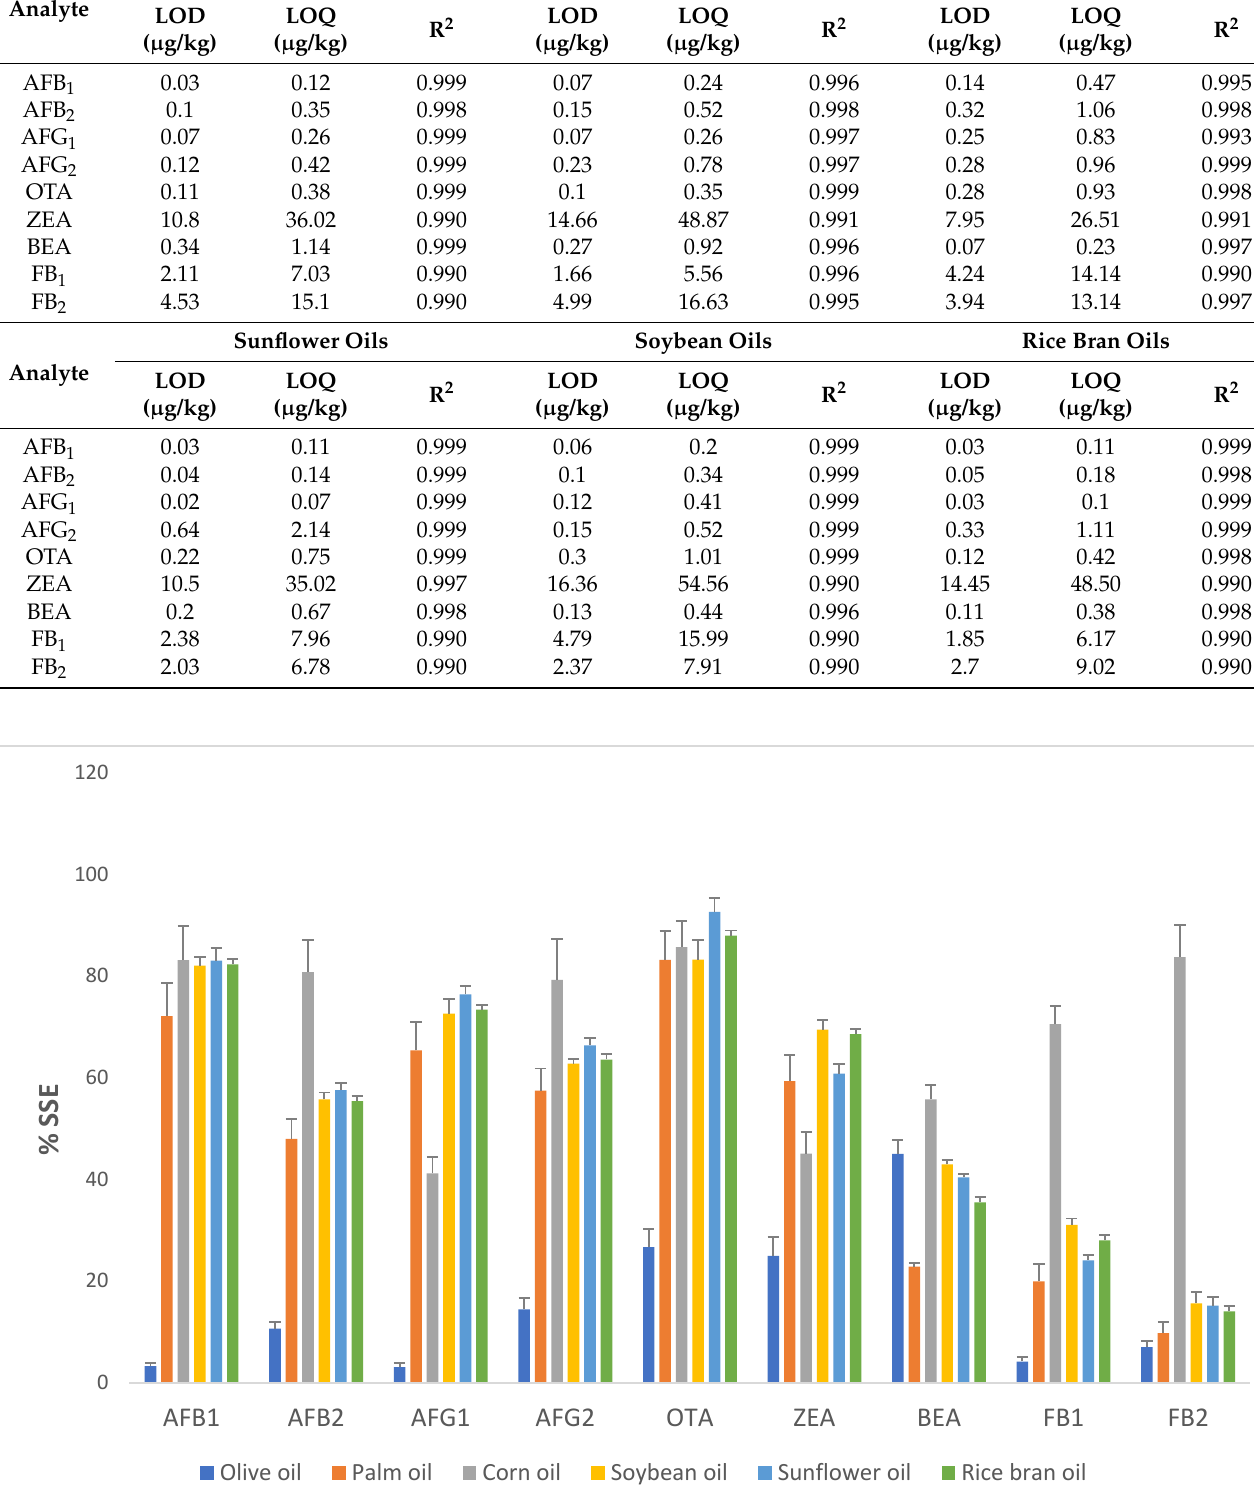
Figure 1. Signal suppression enhancement (%SSE) for nine mycotoxins in matrix-matched calibration.